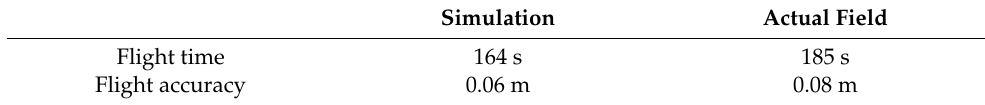
Table 5. Flight performance comparison of simulation and actual field results.